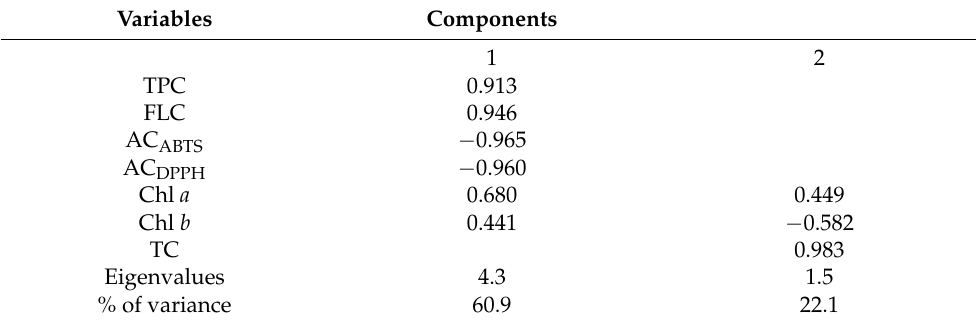
Table 5. Loadings of the significant measured variables on the two principal components (PCs)